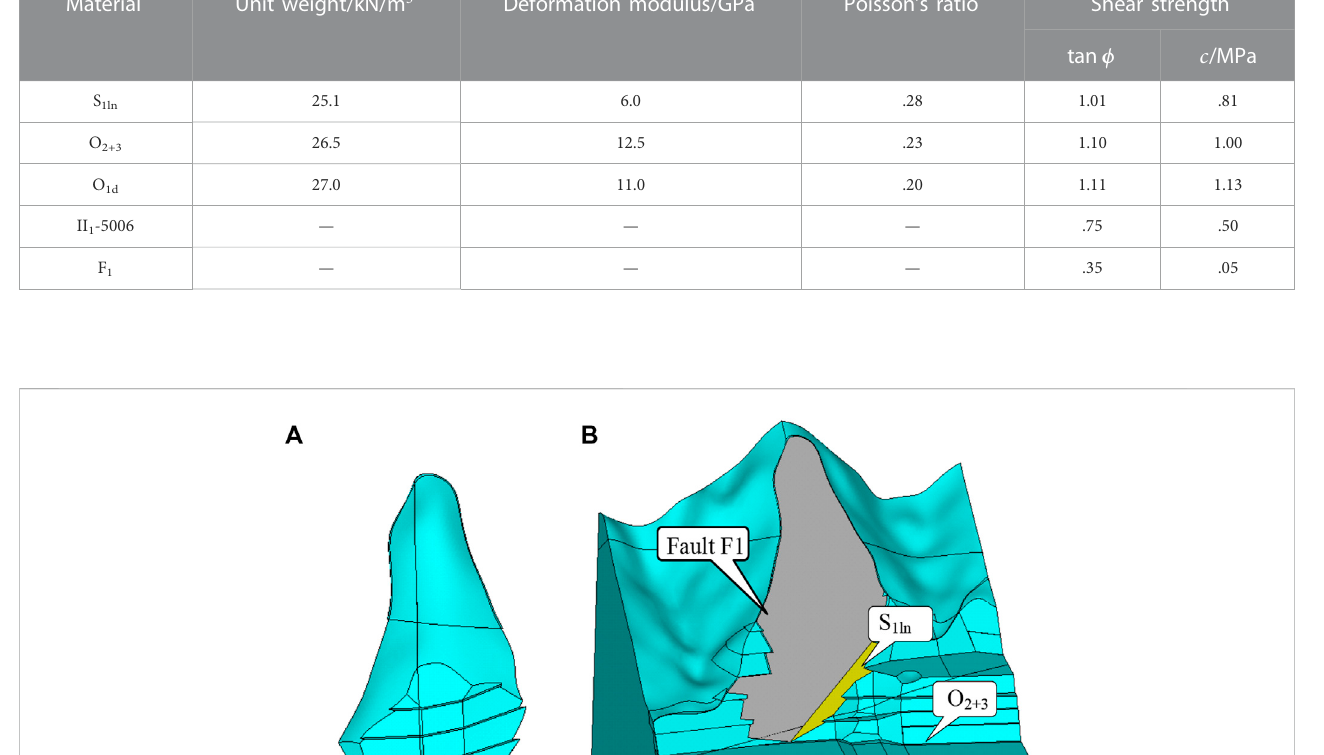
TABLE 7 Physical and mechanical parameters of the rock mass for the right dam abutment slope. Material